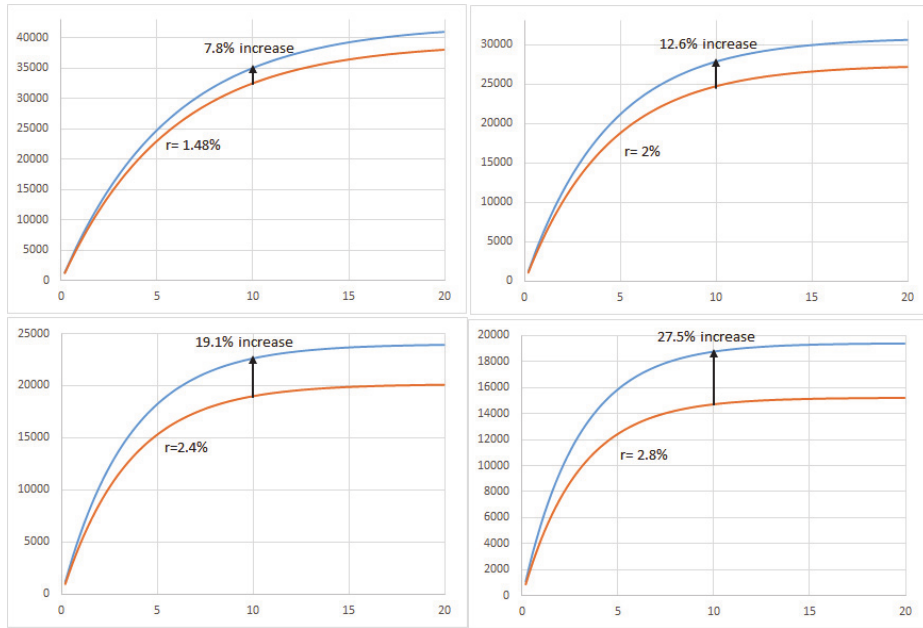
(blue line) and model (cid:1852) (cid:2869)